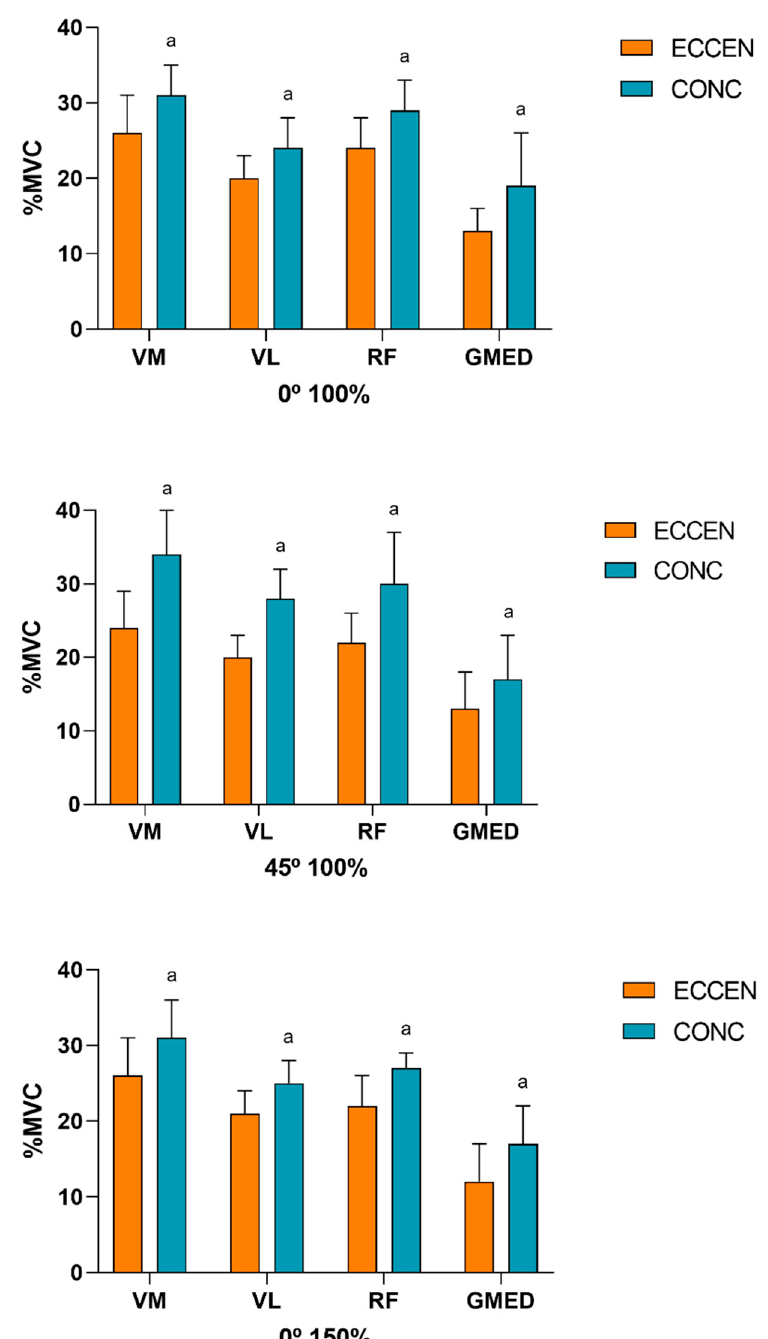
Figure 6. Comparison of the muscle activation (expressed in %MVC) between phases for each muscle under each controlled velocity condition ( ᵃ difference from the eccentric phase; p < 0.05). VMO: vastus medialis oblique; VL: vastus lateralis; RF: rectus femoris; GMED: gluteus medialis. ECCEN: eccentric; CONC: concentric.